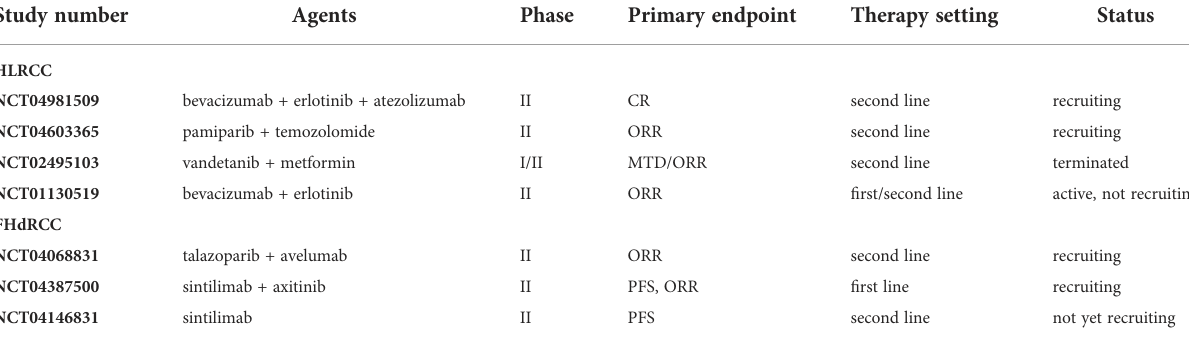
TABLE 1 Ongoing clinical trials in HLRCC and FHdRCC.